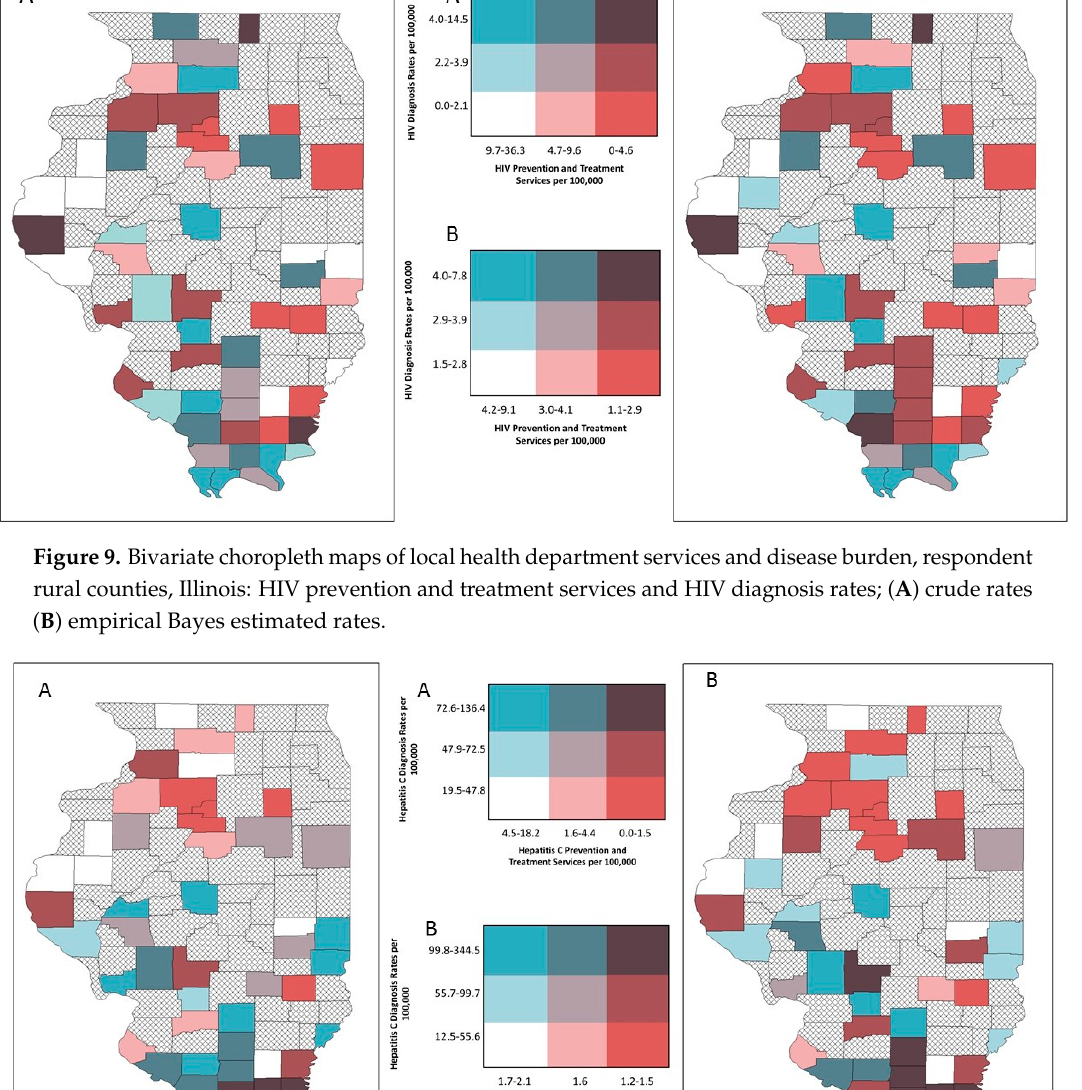
Figure 8. Bivariate choropleth maps of local health department services and disease burden, respondent rural counties, Illinois: opioid-use disorder (OUD) treatment services and opioid overdose rates; ( A ) crude rates ( B ) empirical Bayes estimated rates.